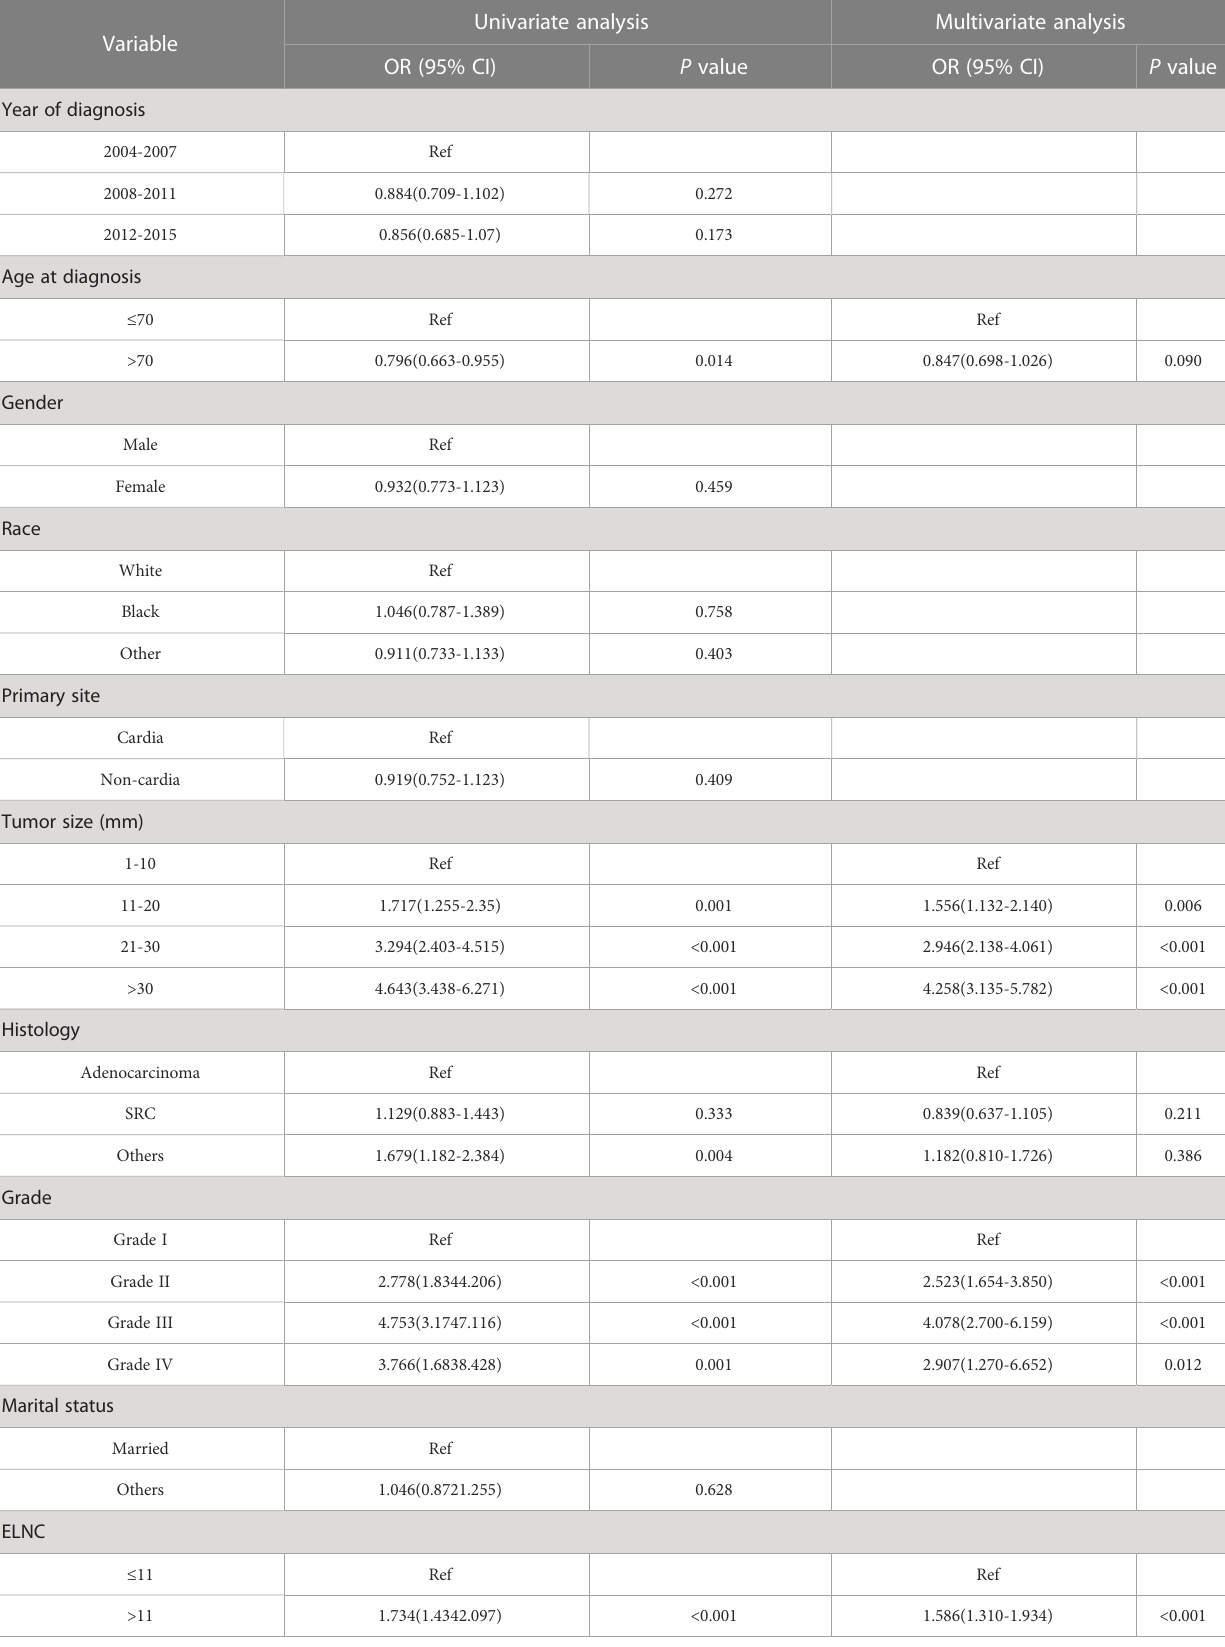
TABLE 3 Univariate and multivariate logistic regression analysis to identify risk factors for LNM in EGC